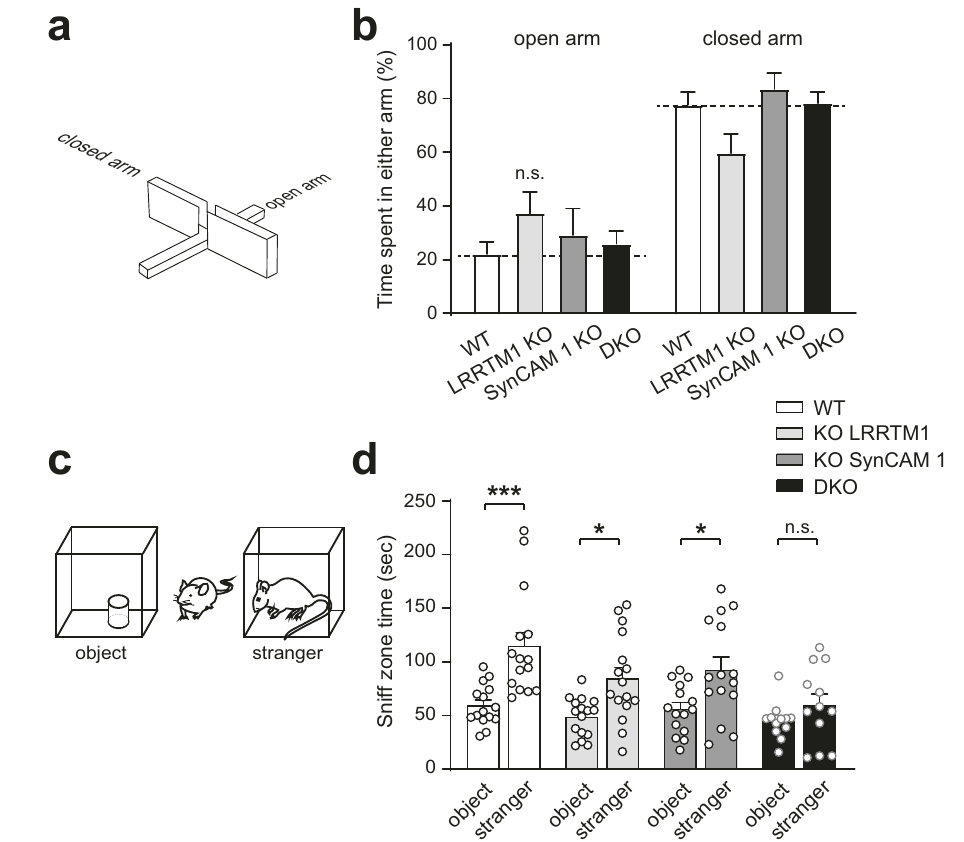
Fig. 6 | No evidence for changes in anxiety but impaired social interactions uponcombineddeletionofLRRTM1andSynCAM1.a Modeloftheelevatedplus mazetoassessanxiety.Miceareplaced inthecenterofaplusmazeandnumberof entriesandlengthoftimespentinopenversusclosedarmswerescored. b WTmice prefer to spend time in the closed arm of the elevated plus maze, and single LRRTM1 and SynCAM 1 KO and DKO mice behave like WT. Dotted lines mark WT times. (One-way ANOVA with Tukey ’ s post hoc test; n =16 WT, 18 LRRTM1 KO, 12 SynCAM1 KO, 11 DKO mice). c Model of the socialpreference test. Mice are placed